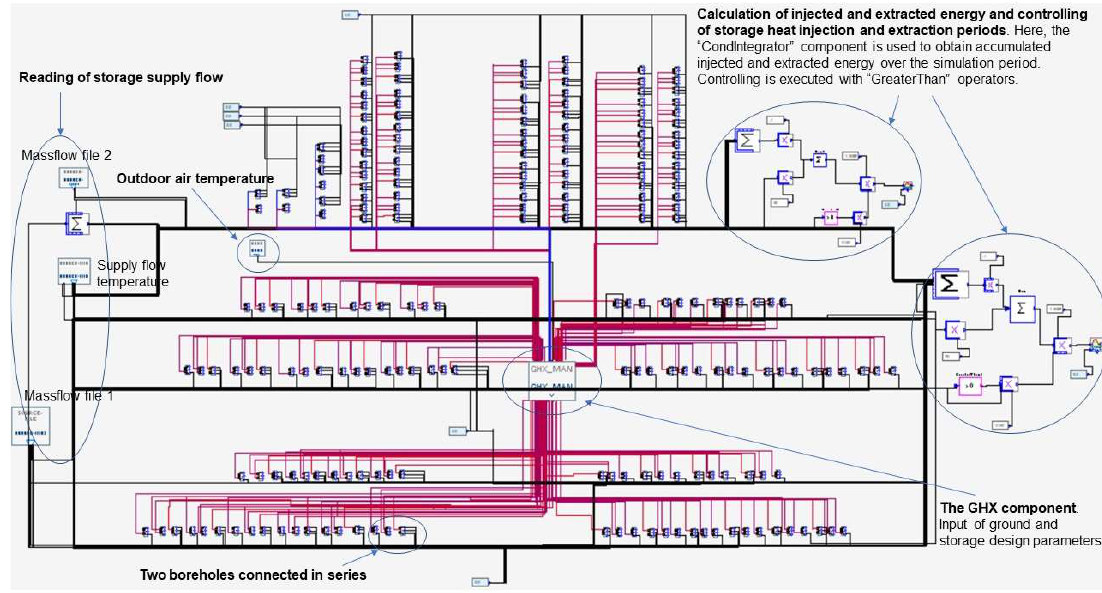
Figure 5. Measured storage supply flow temperature ( a ) and mass flow rate ( b ) at weekly average values.